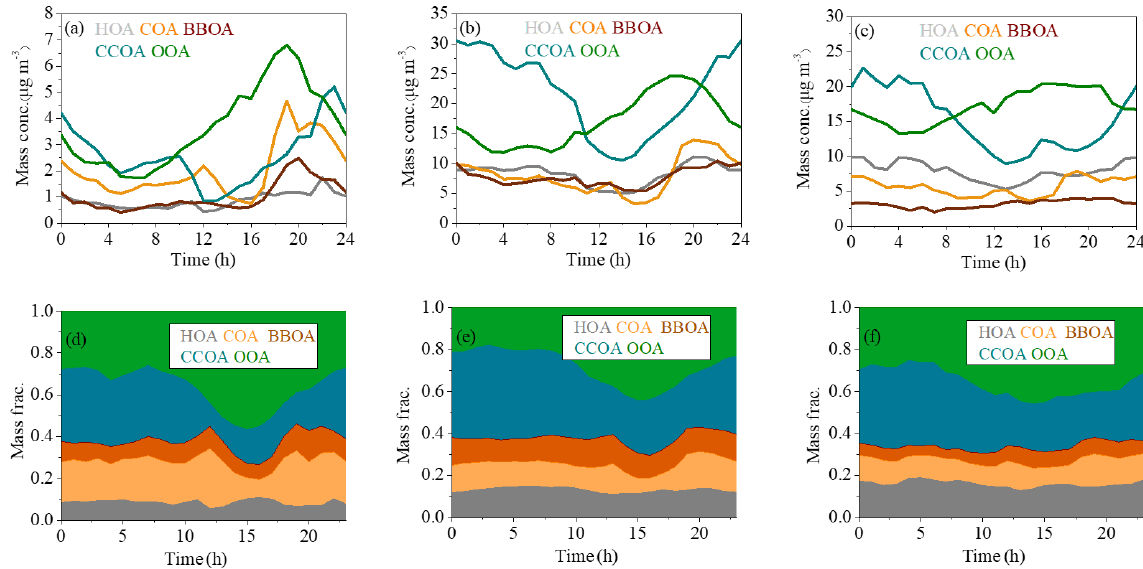
Figure 4. The diurnal variations of mass concentrations and relative contributions of OA factors during clean days (a, d) , low-RH pollution days (b, e) and high-RH pollution days (c, f)